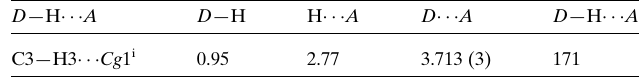
Table 2 Experimental details.